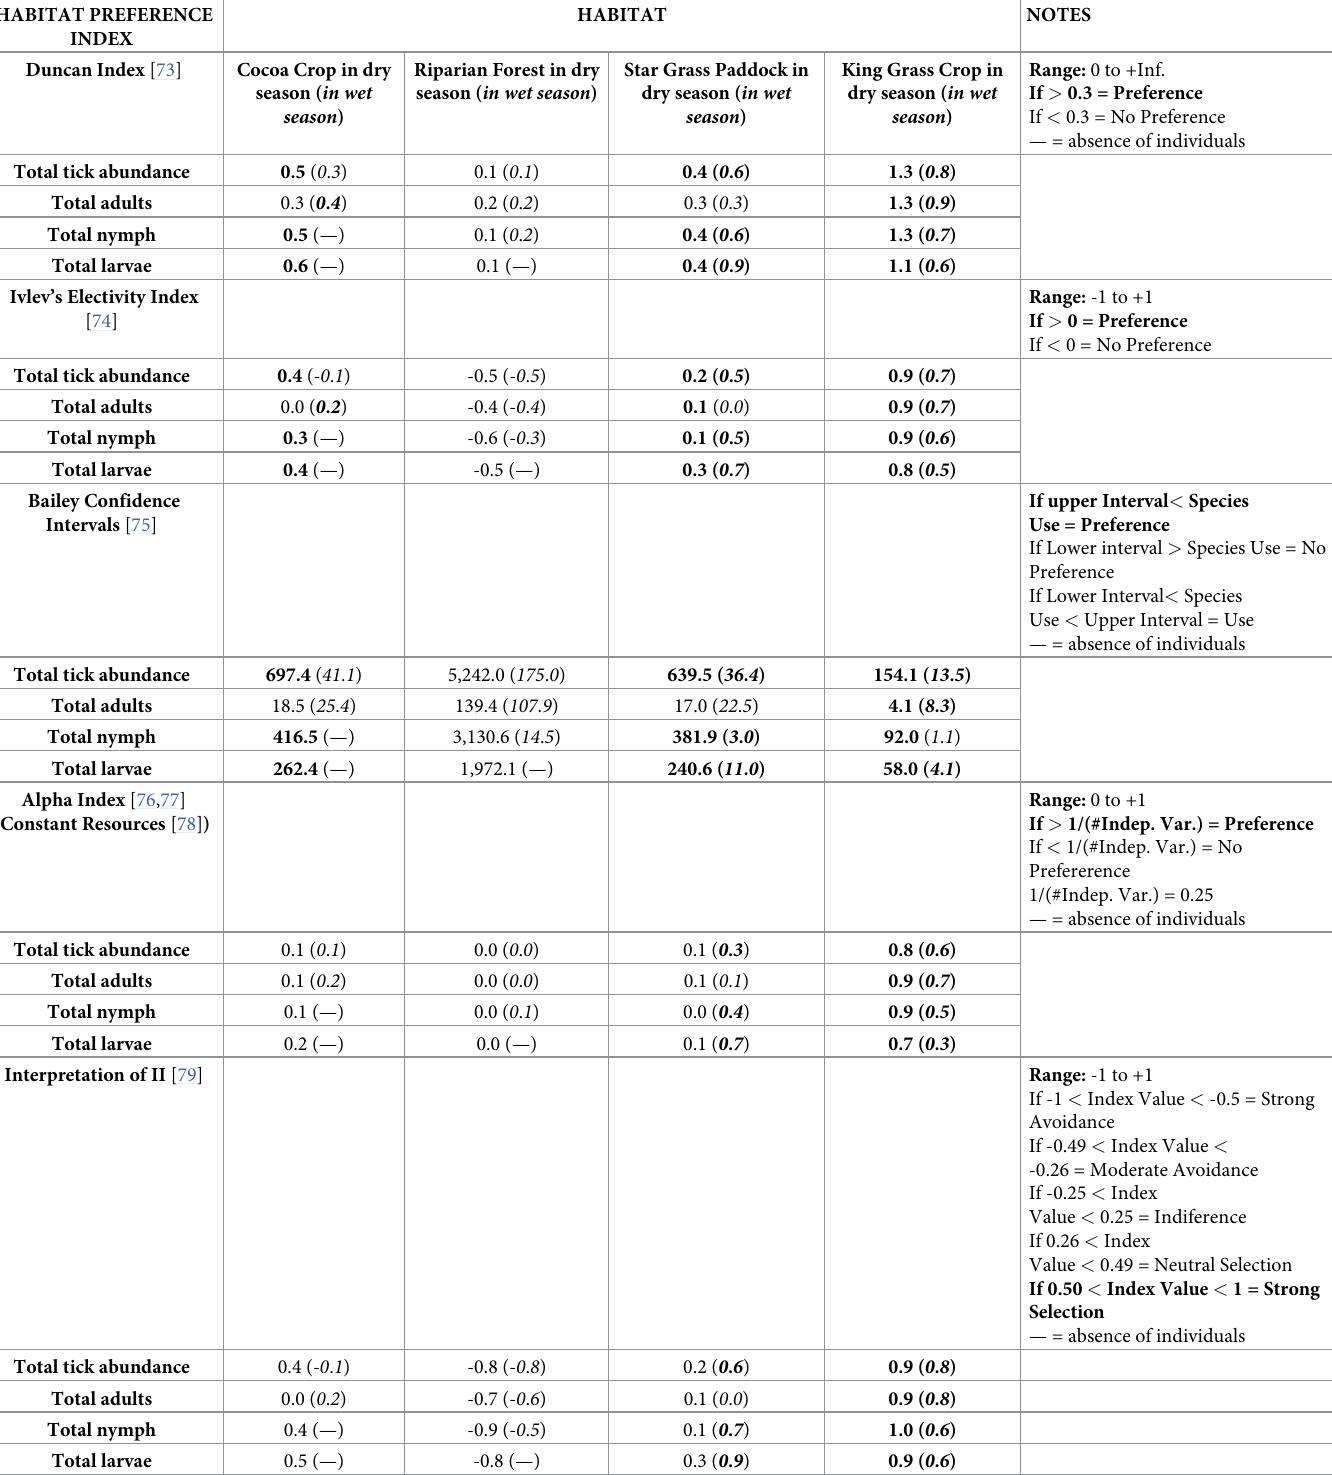
Table 4. Calculations of the best five habitat preferences indices for A . mixtum in the Matepantano Farm by using HaviStat 2.4 1